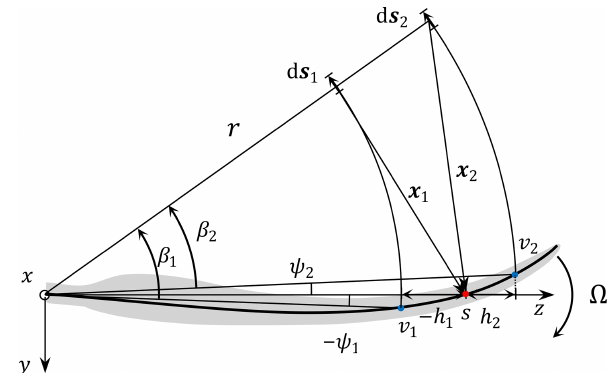
Figure 2. The front view of a backward swept wind turbine blade that is rotating clockwise with the rotational speed (cid:127) and its trailed vortex. The calculation point s is located on the z axis. Two condi- tions are shown for this backward swept blade. Firstly, when the trailing point v 1 is further inboard compared to the calculation point, the relative distance h 1 and the sweep angle ψ 1 are both smaller than zero. Secondly, when the trailing point v 2 is further outboard, the relative distance h 2 and the sweep angle ψ 2 are both larger than zero. The difference of the azimuthal angle of the ele- mentary trailed vorticity d s with respect to the trailing point is β . The position vector x is pointing from the elementary trailed vortex d s to the calculation point s . Please note that the position vector x and the elementary trailed vorticity d s shown in the sketch are their projection into the rotor